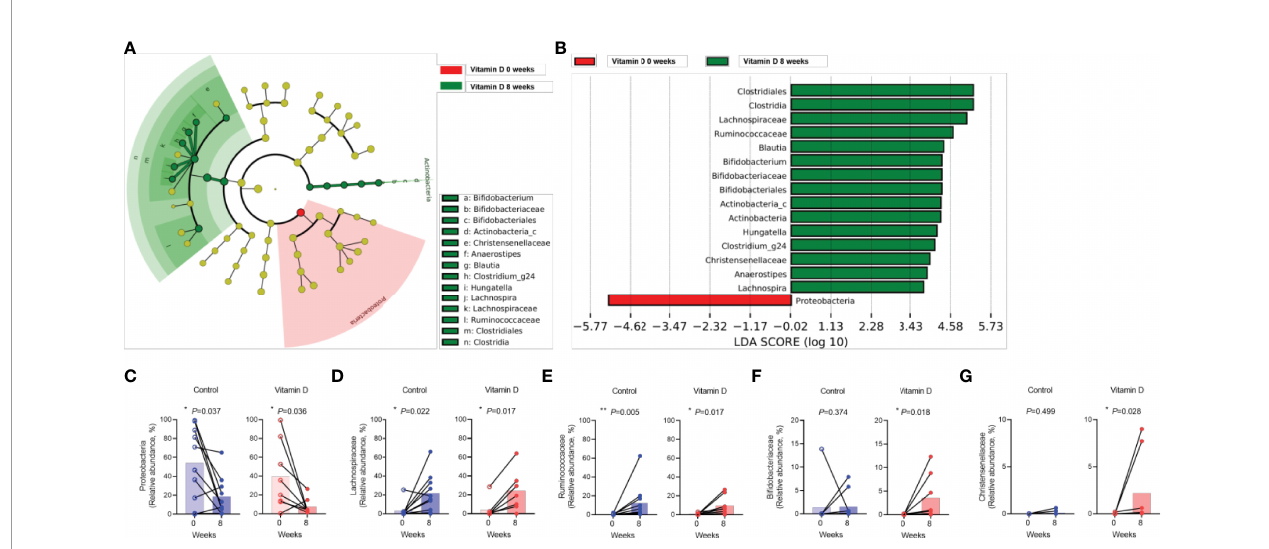
FIGURE 4 | Effect of vitamin D supplementation on the individual gut taxa. A, B. Cladogram (A) and linear discriminant analysis scores (B) using LEfSe analysis of the fecal microbiota in Clostridioides dif fi cile infection versus recovery after eight weeks in the vitamin D treatment group. (C – G) . Differences in the abundance of individual bacteria between the control group and vitamin (D) supplement group. (C) Proteobacteria . (D) Lachnospiraceae . (E) Ruminococcaceae . (F) Bi fi dobacteriaceae . (G) Christensenellaceae . *P < 0.05, **P < 0.01 (Wilcoxon signed rank